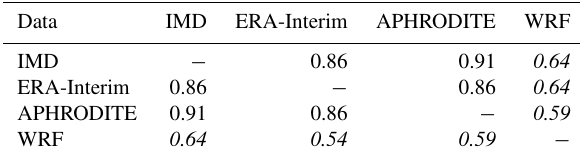
Figure 11. Annual precipitation at the Bhuntar gauge. Data at the nearest point to the Bhuntar gauge are extracted from the gridded datasets. Table 4. Pearson’s correlation of annual precipitation series. The italics indicate the minimum values by row and by